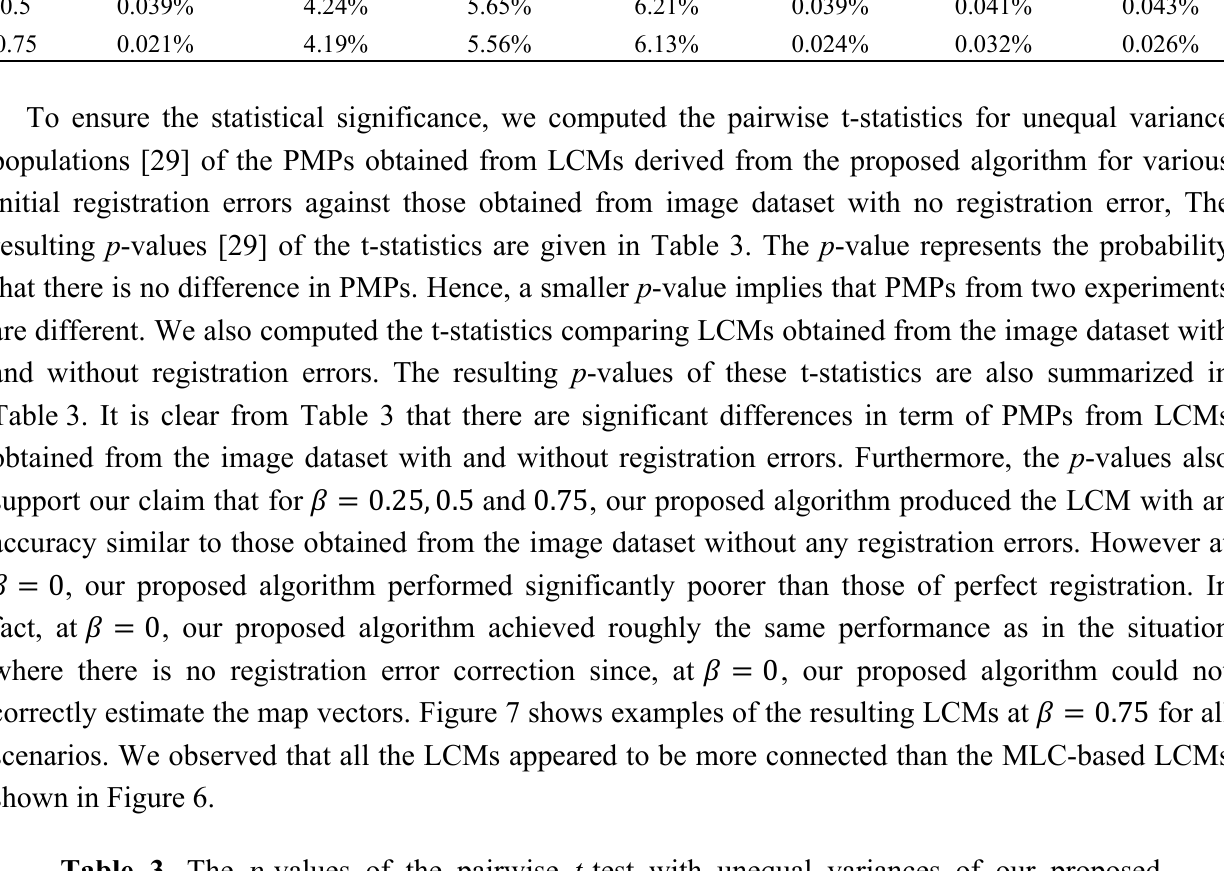
Table 3. The p -values of the pairwise t -test with unequal variances of our proposed algorithm to the perfect registration cases. No registration error correction to the perfect registration